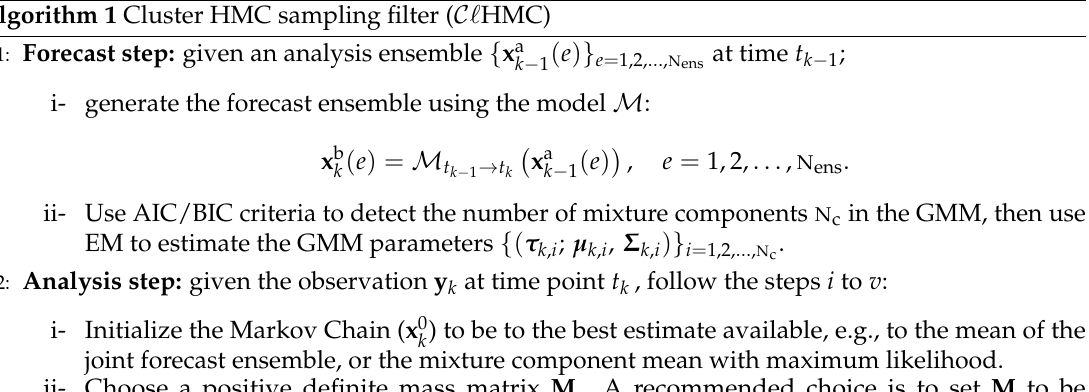
Algorithm 1 Cluster HMC sampling filter (